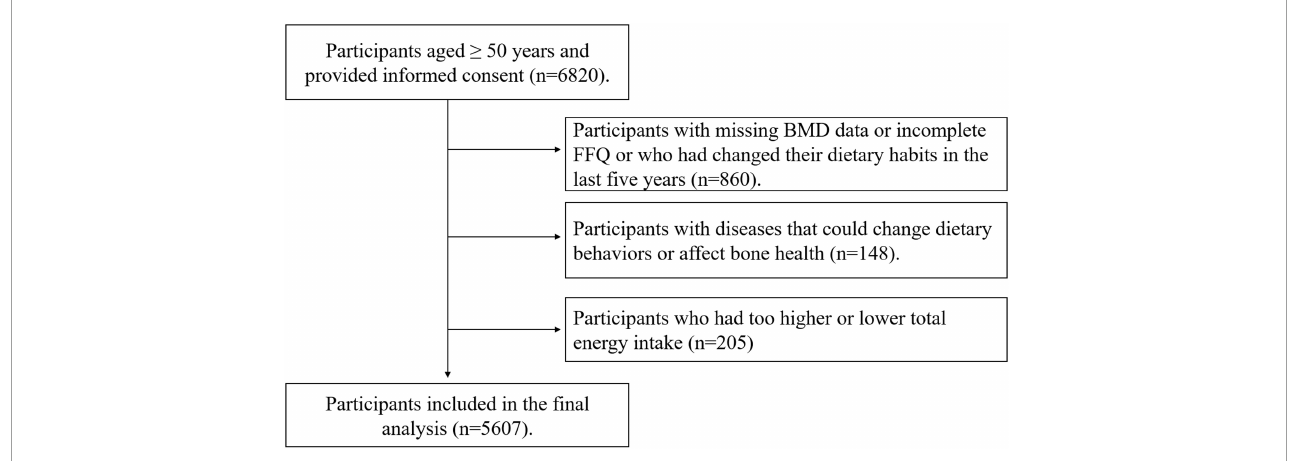
FIGURE1 Flow diagram showing the selection of the